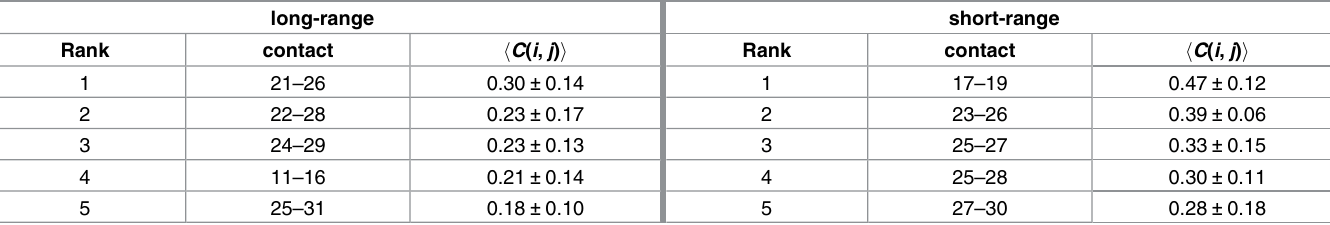
Table 3. Five top side chain contacts in A β 10-40peptide for C36s force